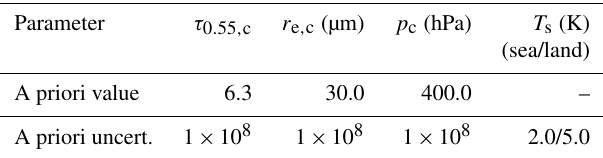
Table 6. Ice cloud a priori values and associated uncertainties.